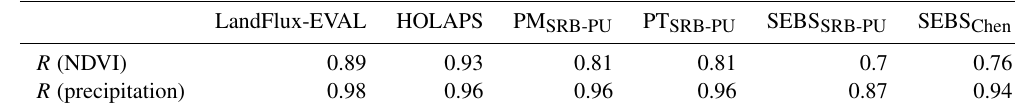
Table 2. Correlation coefficient ( R ) between averaged LE and NDVI, precipitation over the TP for the time 2001–2005.